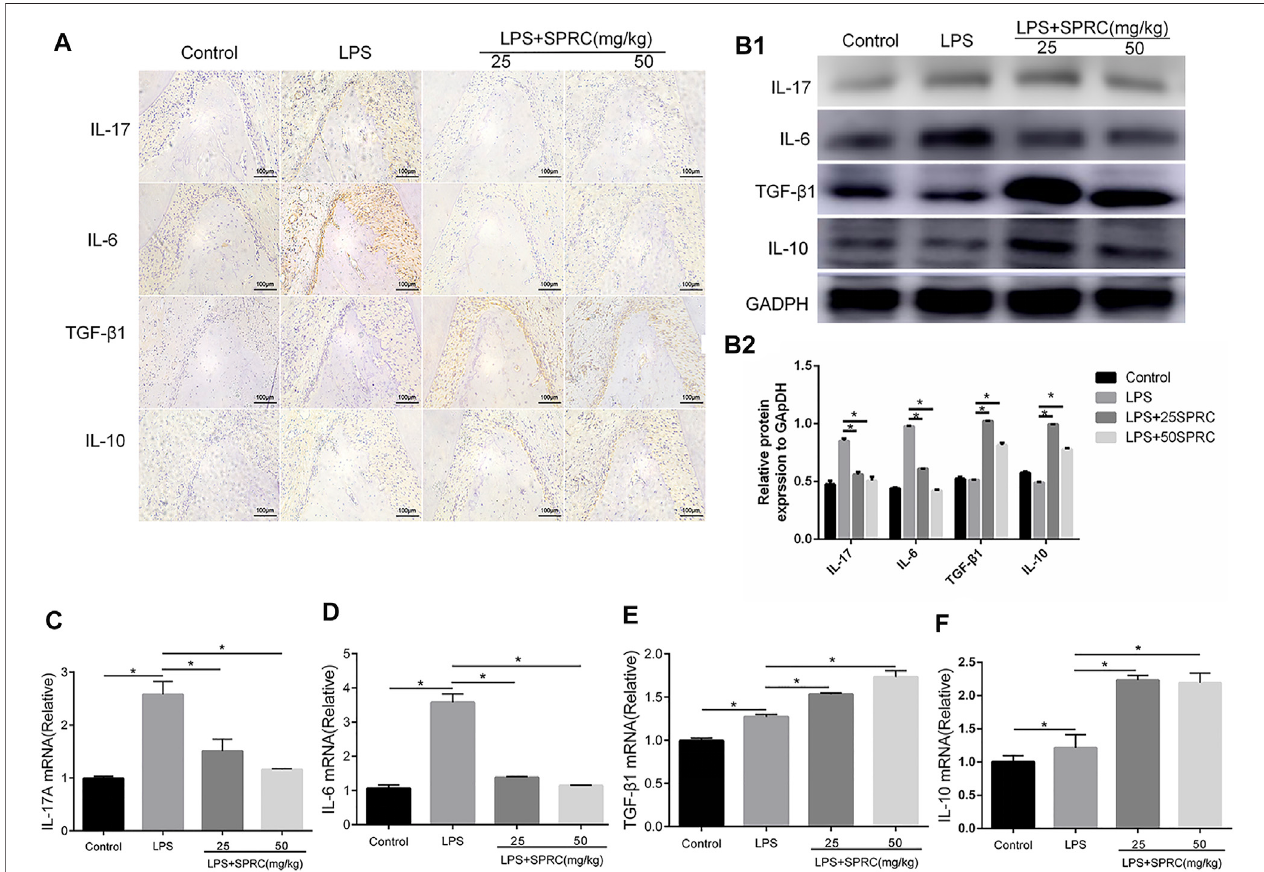
FIGURE5| Effect ofSPRC onTh17/Tregcell – related cytokines. (A) Immunohistochemical localizationassaysforIL-17A,IL-6, IL-10and TGF- β 1proteiningingival tissue ( × 200magni fi cation scale bar (cid:1) 100 μ m), (B1) Western blot assays for IL-17A, IL-6, IL-10 and TGF- β 1 protein in gingival tissue. (B2) Quantitative analysis of westernblotresults., (C – F) HistogramexpressionofRT-PCRassaysforIL-17A,IL-6,IL-10andTGF- β 1mRNAingingivaltissue,Dataareshownasthemeans ± SDfrom 4 animals. *p < 0.05 vs. LPS group.